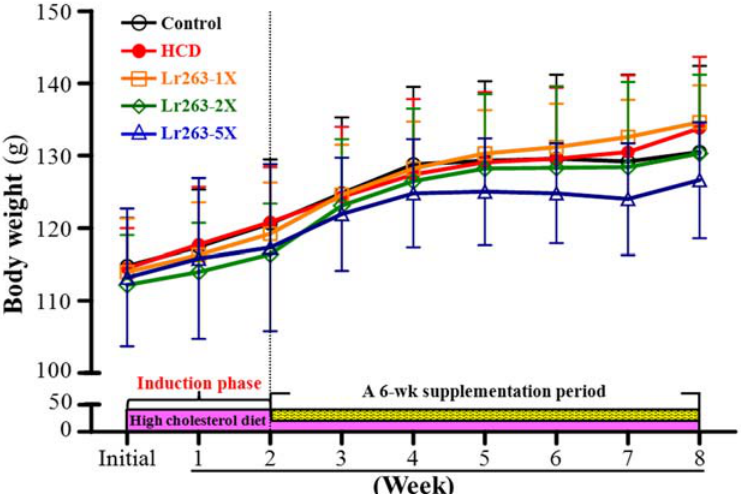
Figure 2. Change in BW during the experiment. The first week was an adaption phase. At two weeks, animals were separated into the control group and fed a standard laboratory diet (eight hamsters) or experimental animals and fed an HCD of the standard laboratory diet supplemented with 0.2% cholesterol and 10% lard (32 hamsters). Serum triglycerides (TG) and total cholesterol (TC) levels were higher for HCD than control hamsters. The 32 hamsters were randomly assigned to three groups (eight hamsters/group) for Lr263 supplementation. Data are mean ± SD, n = 8 per